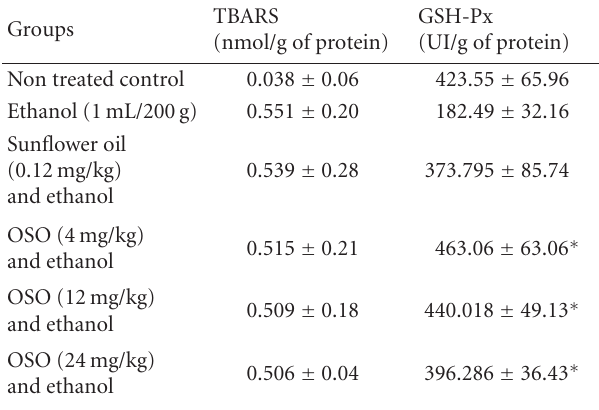
Table 2: Thiobarbituric acid-reactive substances (TBARS) and glu- tathione peroxidase (GSH-Px) in gastric mucosal damage induced by ethanol and pretreated with OSO. Data are expressed as nmol/mg prot of TBARS. The results are the means ± s.e.m. of five stomachs samples.